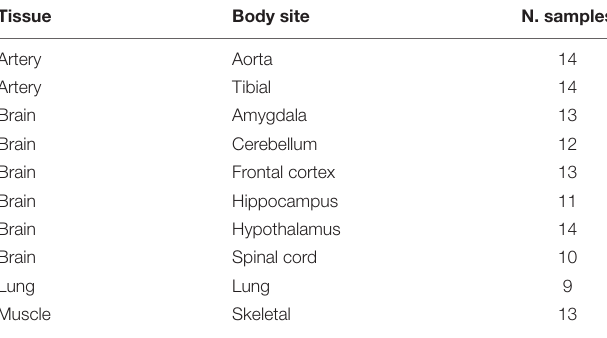
TABLE 1 | Summary table of experiments